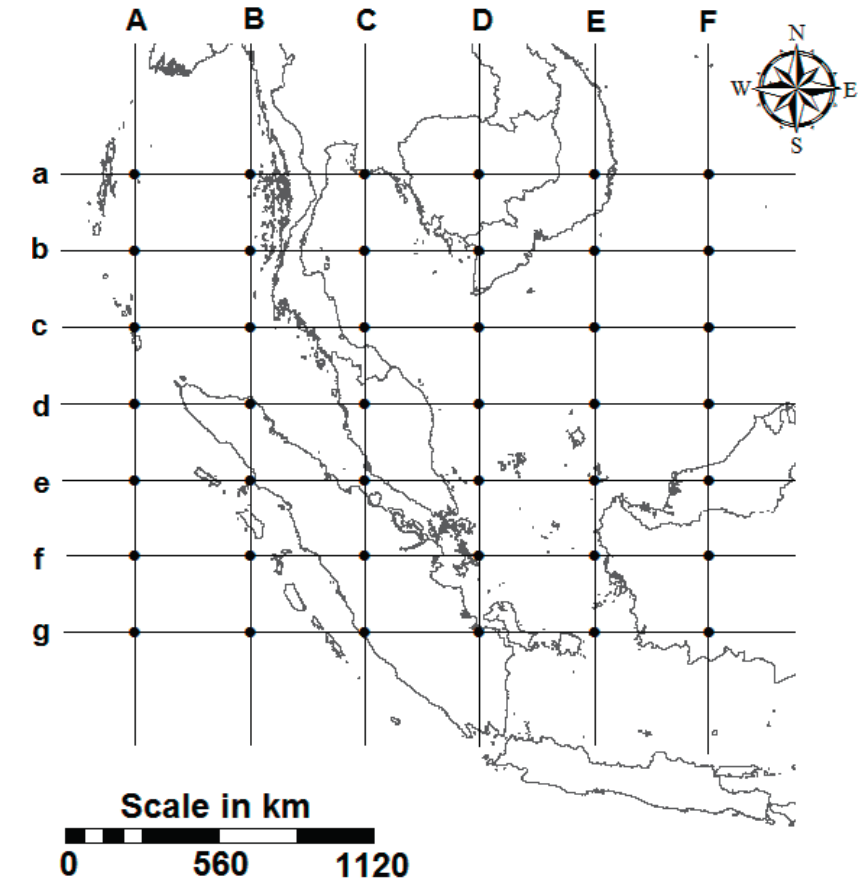
Figure 2. Location of NCEP grid points used to select the